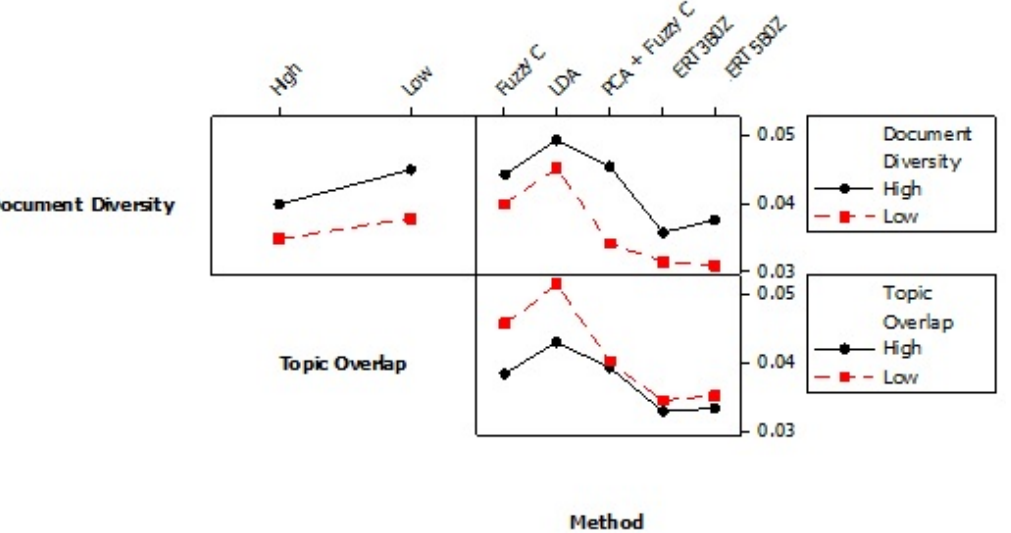
Figure 8. Interaction plot for topic definition minimum average root mean squares (MARMS).